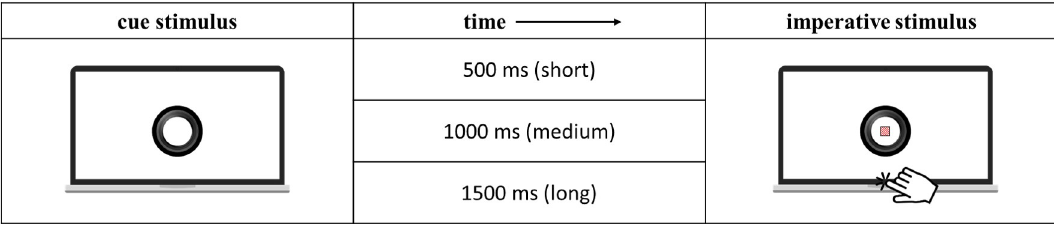
Fig 1. Representation of the DTP task. The visual cue consisted of a black circle representing the lens of a camera. This cue warned children of the upcoming presentation of the imperative stimulus appearing at its centre. The imperative stimulus is here represented with the striped square for illustrative purposes due to copyright restrictions. Participants had to make speeded responses at the target stimulus onset by pressing the laptop spacebar.